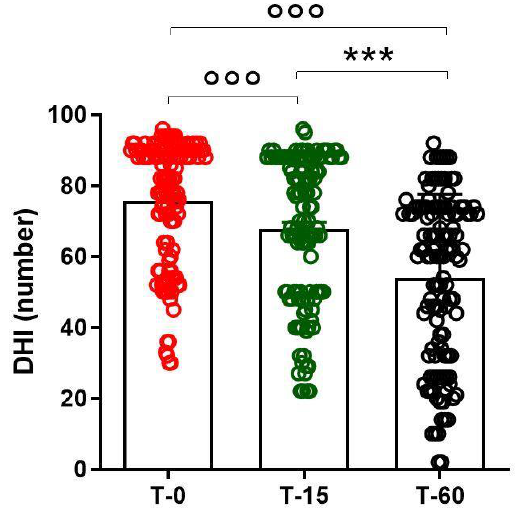
Figure 2. Reduction of dizziness symptoms, evaluated using the Dizziness Handicap Inventory (DHI), assessed at different times after pharmacological treatment with a fixed-combination preparation of cinnarizine (20 mg) plus dimenhydrinate (40 mg). Data refer to n = 120 patients, and are represented as the mean ± SD of DHI symptoms. *** p < 0.001 vs. T15; ◦◦◦ p < 0.001 vs. T0. T0: baseline; T15: evaluation after 15 days from the start of therapy; T60: evaluation at the end of therapy.